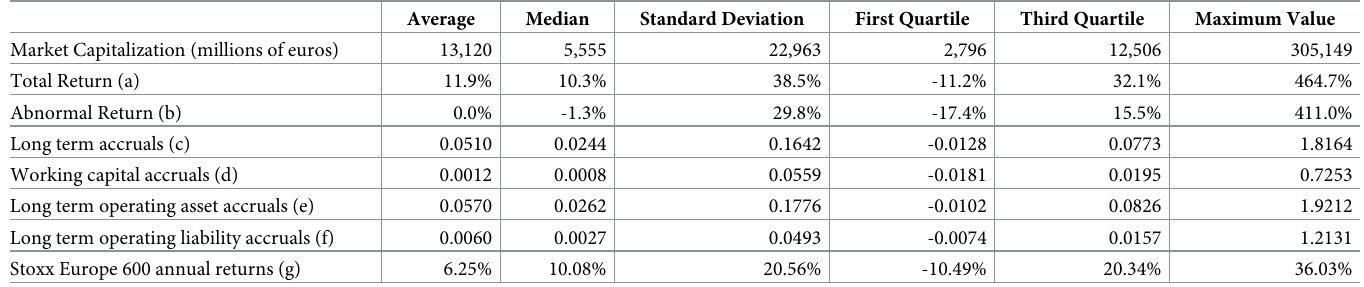
Table 1. Descriptive statistics.